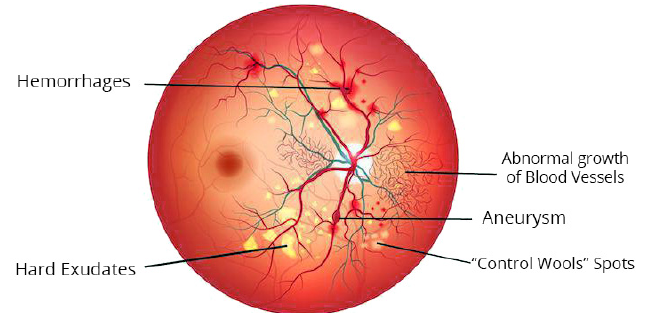
Figure 3. Typical lesions in color fundus image with DR.